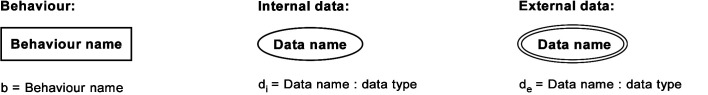
 Graphical and textual representations of BDRML primitives. Reproduced from (Pitonakova et al., 2017) with permission of the copyright holder, IEEE.